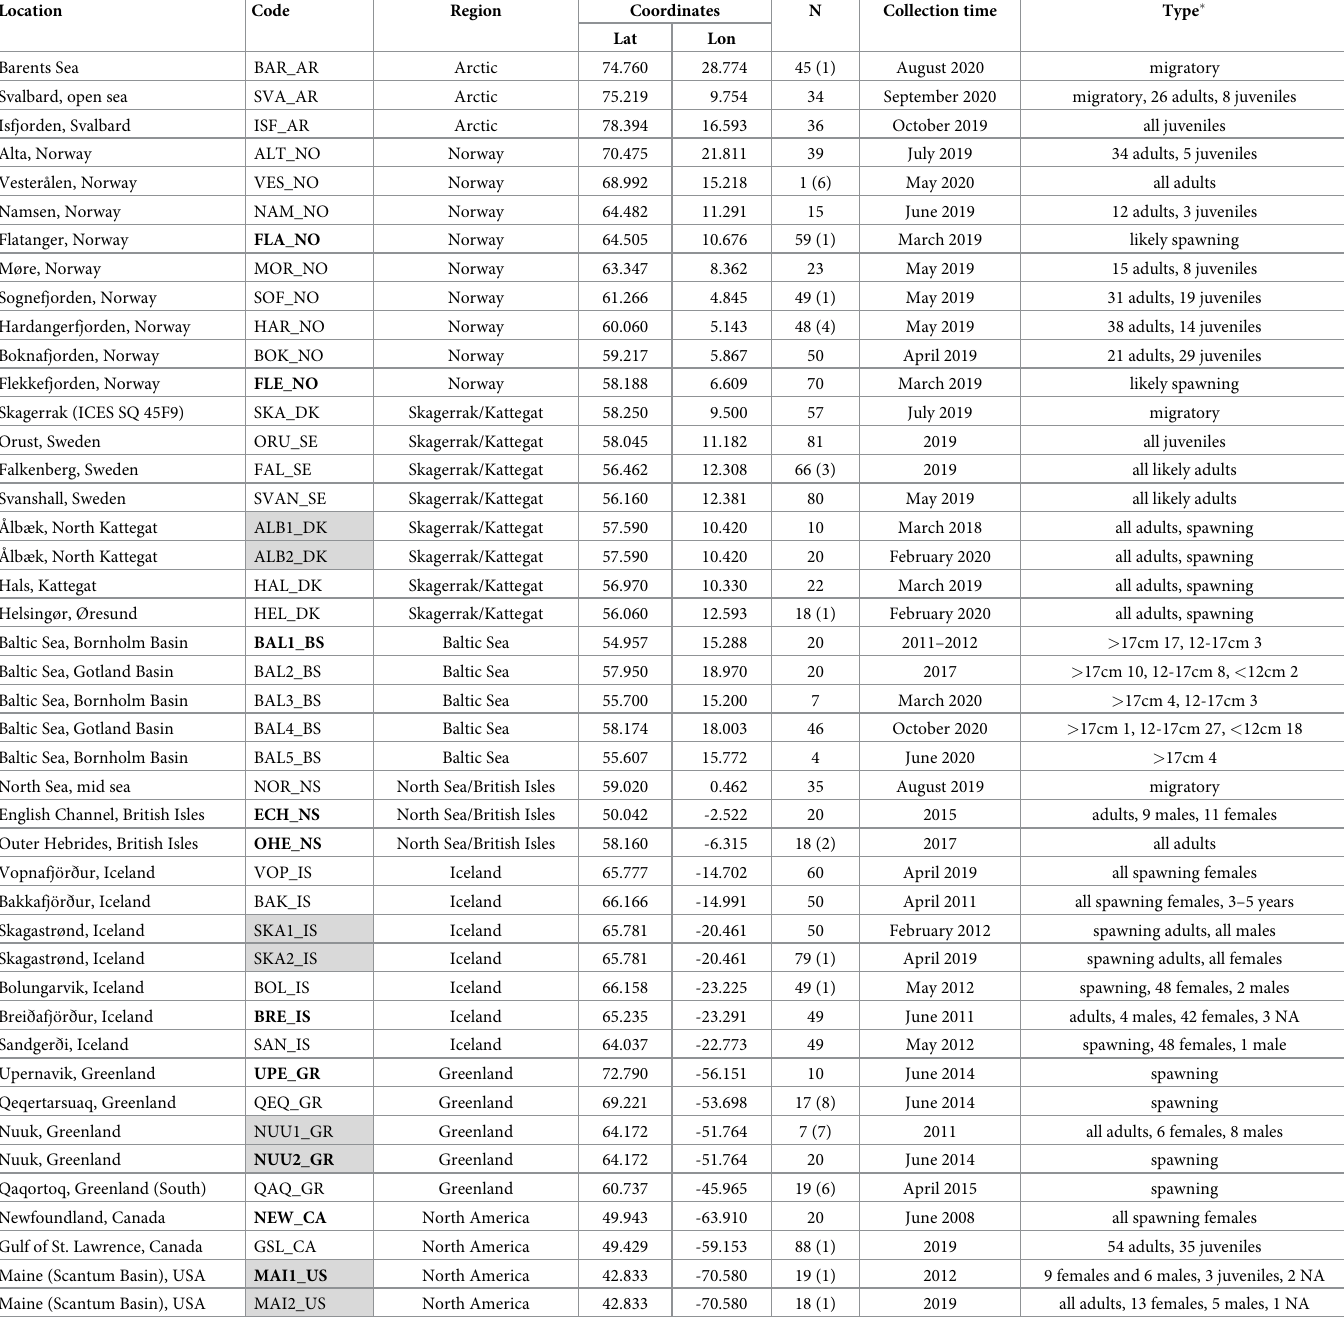
Table 1. Information of samples ordered from east to west and from north to south. The coordinates are approximate. Sample codes shown with grey backgrounds are temporal replicates from the same location. Bold codes denote samples with both SNP and genome wide data. Baltic Sea samples were not considered temporal repli- cates as they were collected from a wider area as part of different surveys. N displays number of individuals after filtering, followed by the number of individuals which did not pass filtering in brackets. Additional metadata can be found in S2 File.